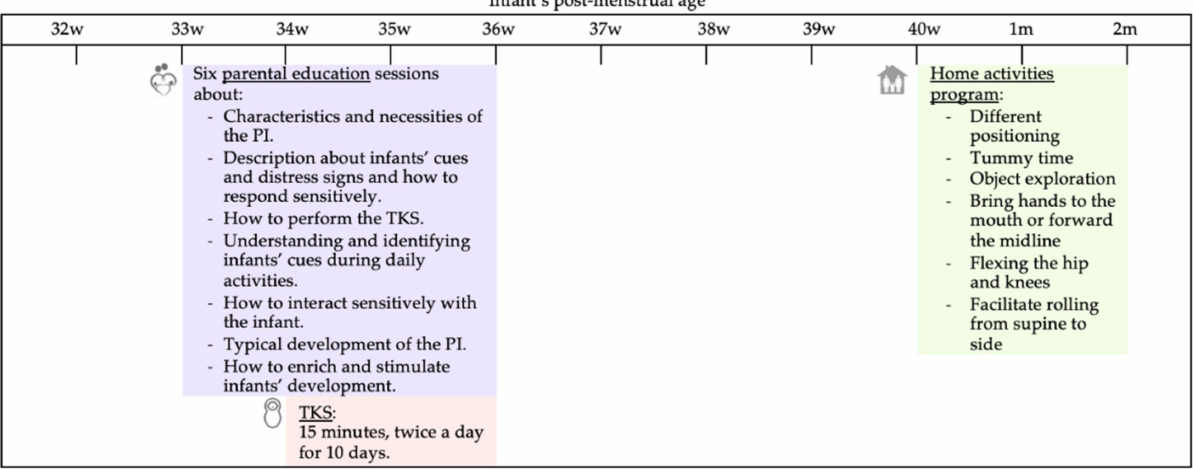
Figure 1. Example of the intervention protocol for a preterm infant born at 31 weeks of gestational age. The protocol was adapted depending on the infant’s gestational weeks at birth. PI: preterm infant; TKS: tactile-kinesthetic